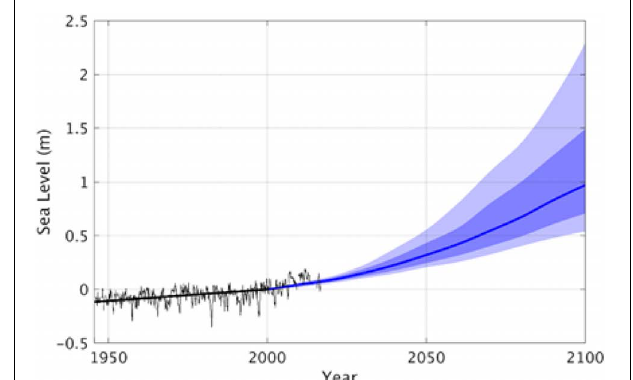
FIGURE 9 | Tide gauge observations (black lines) combined with sea level projections (blue) with RCP 8.5 scenarios at Kwajalein, Marshall Islands (Jackson and Jevrejeva, 2016). The thin black line is monthly tide gauge record, the thick black line is long-term linear trend; the thick blue line is sea level projection at 50% probability, and the dark and light blue shading areas represent 17–83 and 5–95% probabilities,